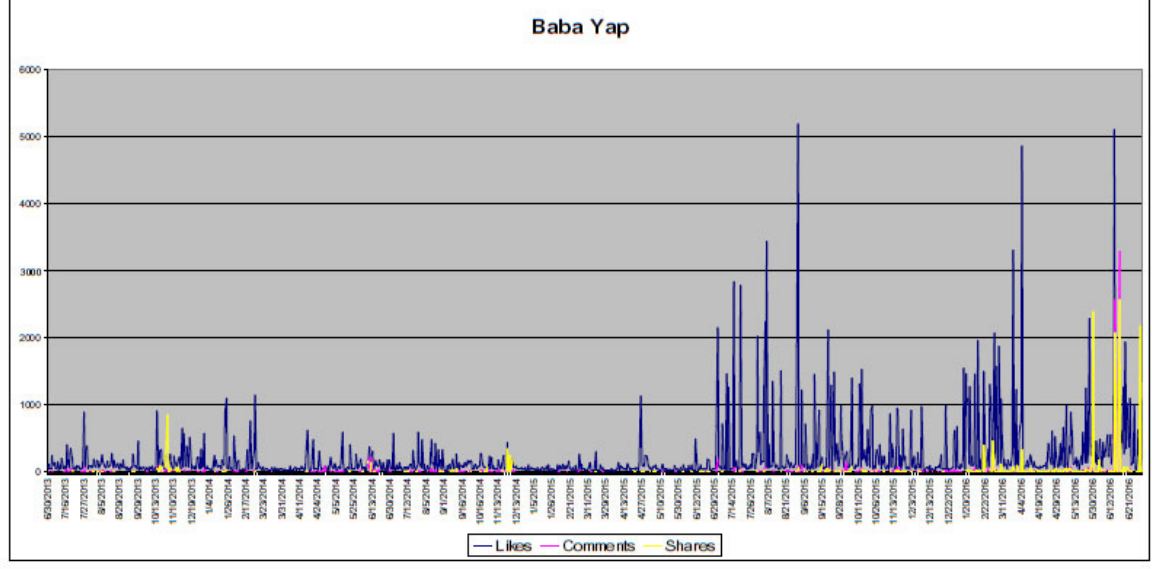
Figure 7: Facebook Activity for Mayor Baba Yap (source: